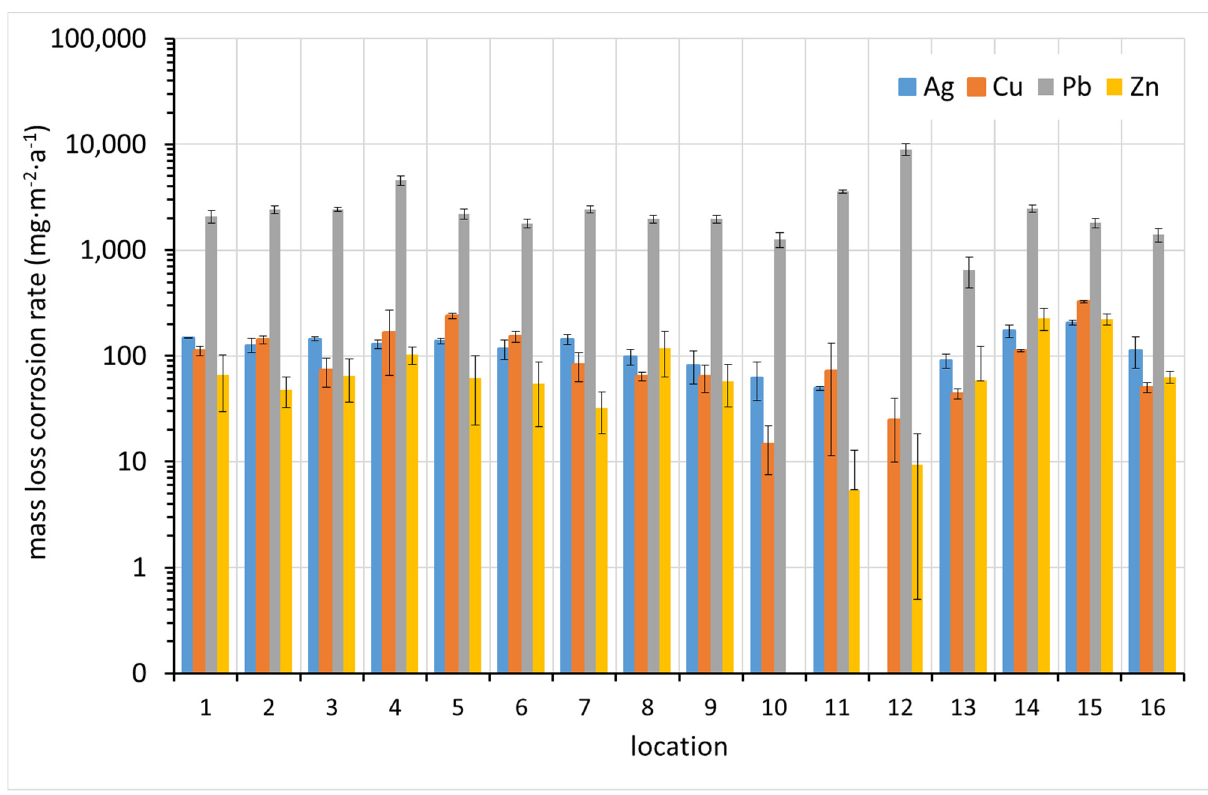
Figure 8. Corrosion rate of coupons based on mass loss (average values from up to three replicates supplemented with standard deviation error bars where applicable).